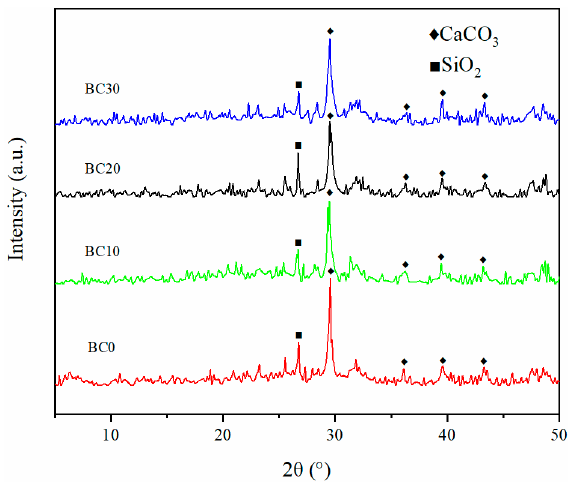
Figure 4. Comparison of XRD patterns plotted for biochars derived from HS-PP blends.